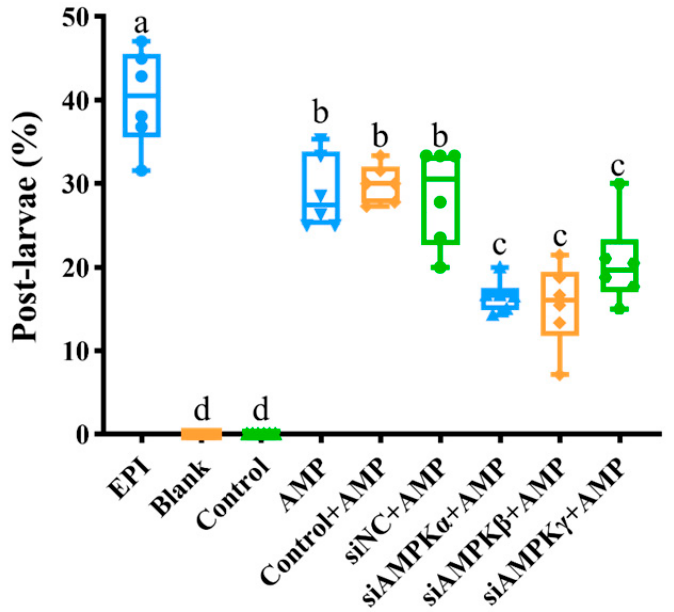
Figure 12. The larval metamorphosis of M. coruscus at 72 h after McAMPK RNAi. Control: electropora- tion; Control + AMP: electroporation + AMP; siRNA + AMP: negative control siRNA + electroporation + AMP; siAMPK α + AMP: McAMPK α siRNA + electroporation + AMP; siAMPK β + AMP: McAMPK β siRNA + electroporation + AMP; and siAMPK γ : McAMPK γ siRNA + electroporation +